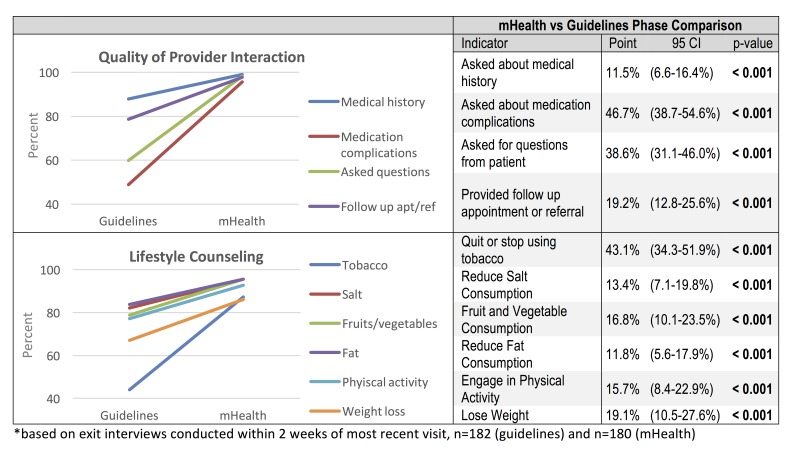
Figure 3. Change in Provider Interaction and Lifestyle Counseling between Phases*